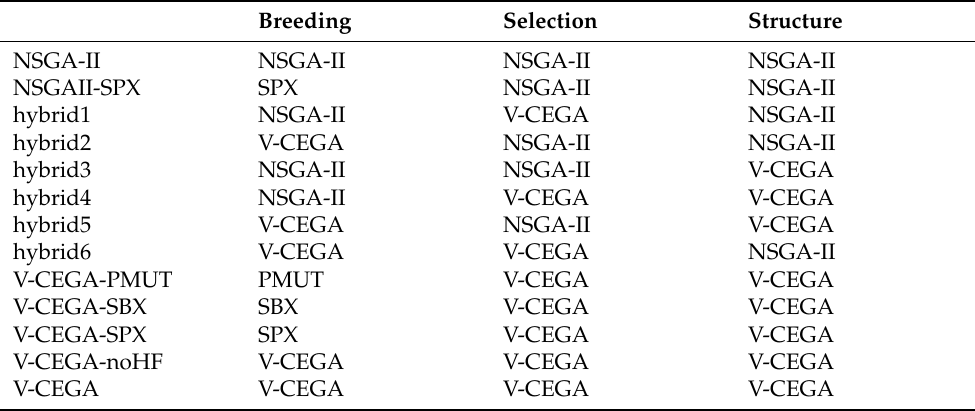
Table 1. Summary of the key features of the set of designed algorithms. Breeding Selection